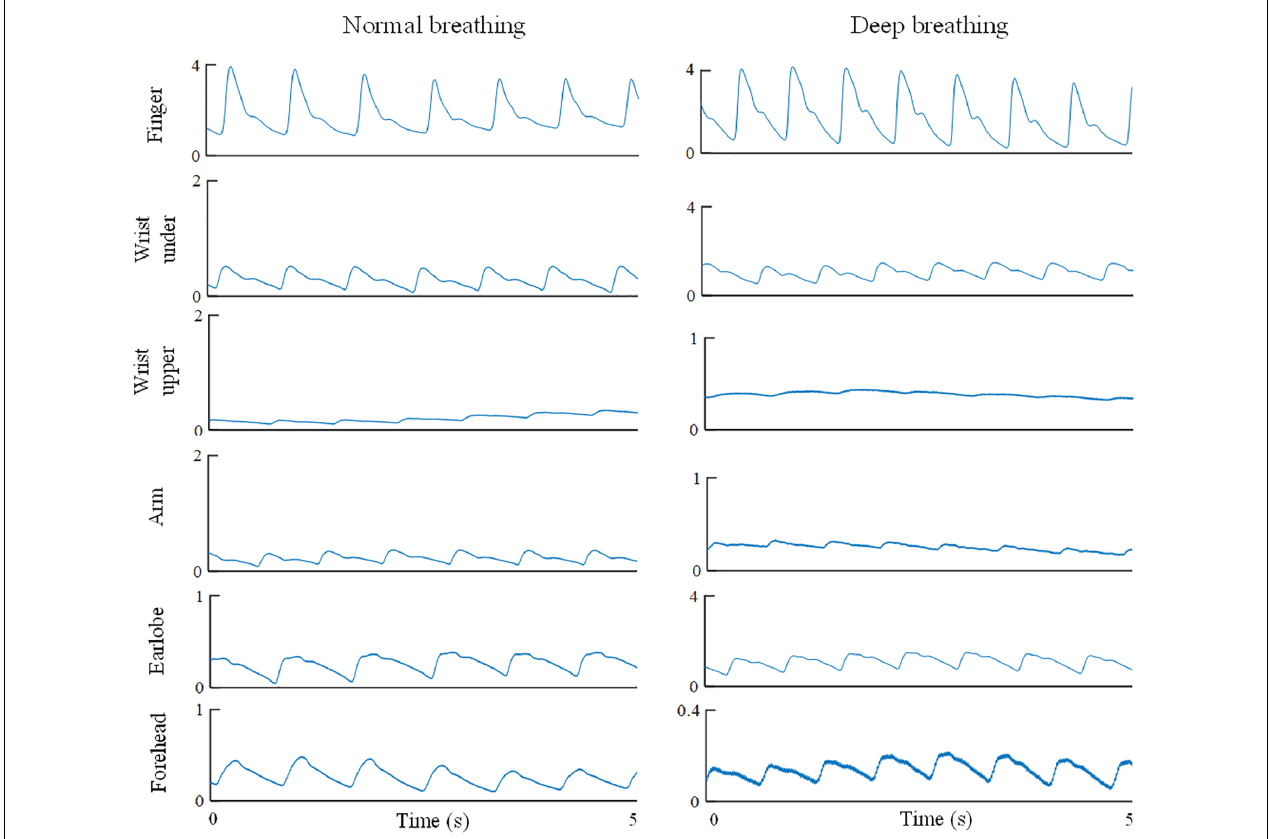
FIGURE 2 | Illustration of recorded PPG waveforms of one subject from different body sites under both normal and deep breathing patterns. Five-second segments were extracted from the 1-min recording.